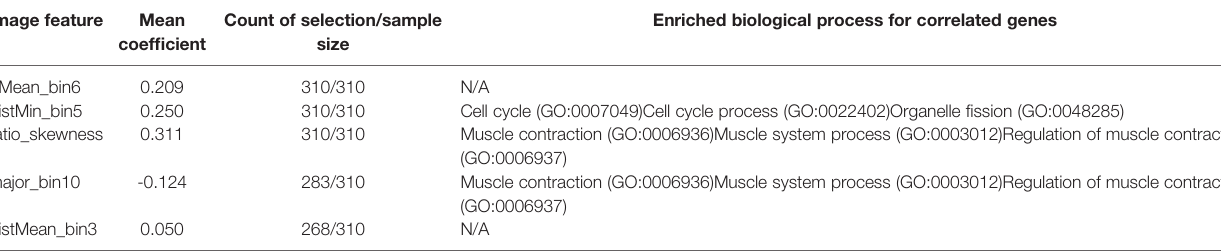
Enriched biological process for correlated